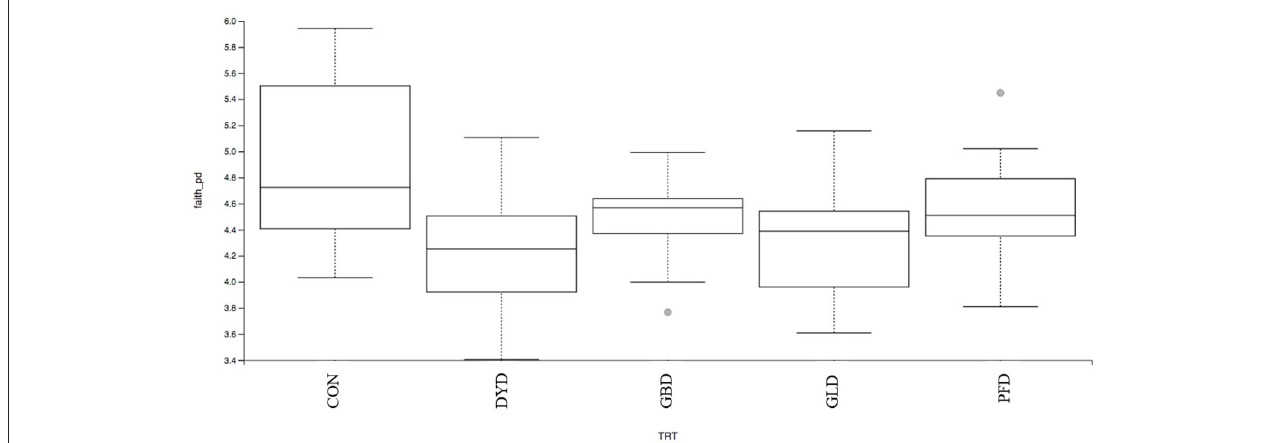
FIGURE 5 | Alpha-diversity analysis of fecal microbial communities, measured by Faith’s phylogenetic diversity (PD), of dogs fed diets containing legumes or yeast as the primary protein source. CON, Poultry by-product meal control; GBD, Garbanzo bean; GLD, Green lentil; PFD, Peanut flour; DYD, Dried